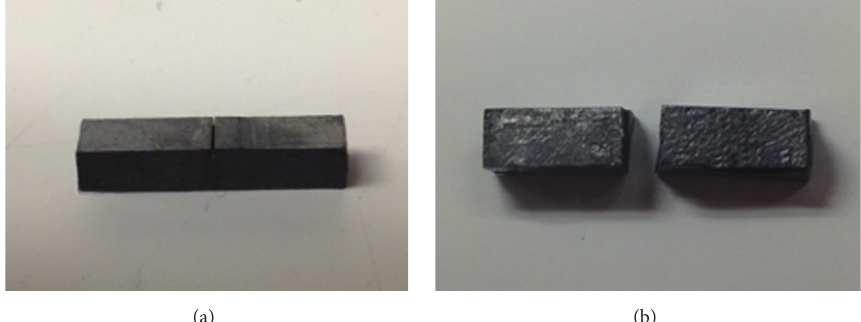
Figure 6: Samples for the dynamic fracture tests: (a) sample before test, (b) sample after test.